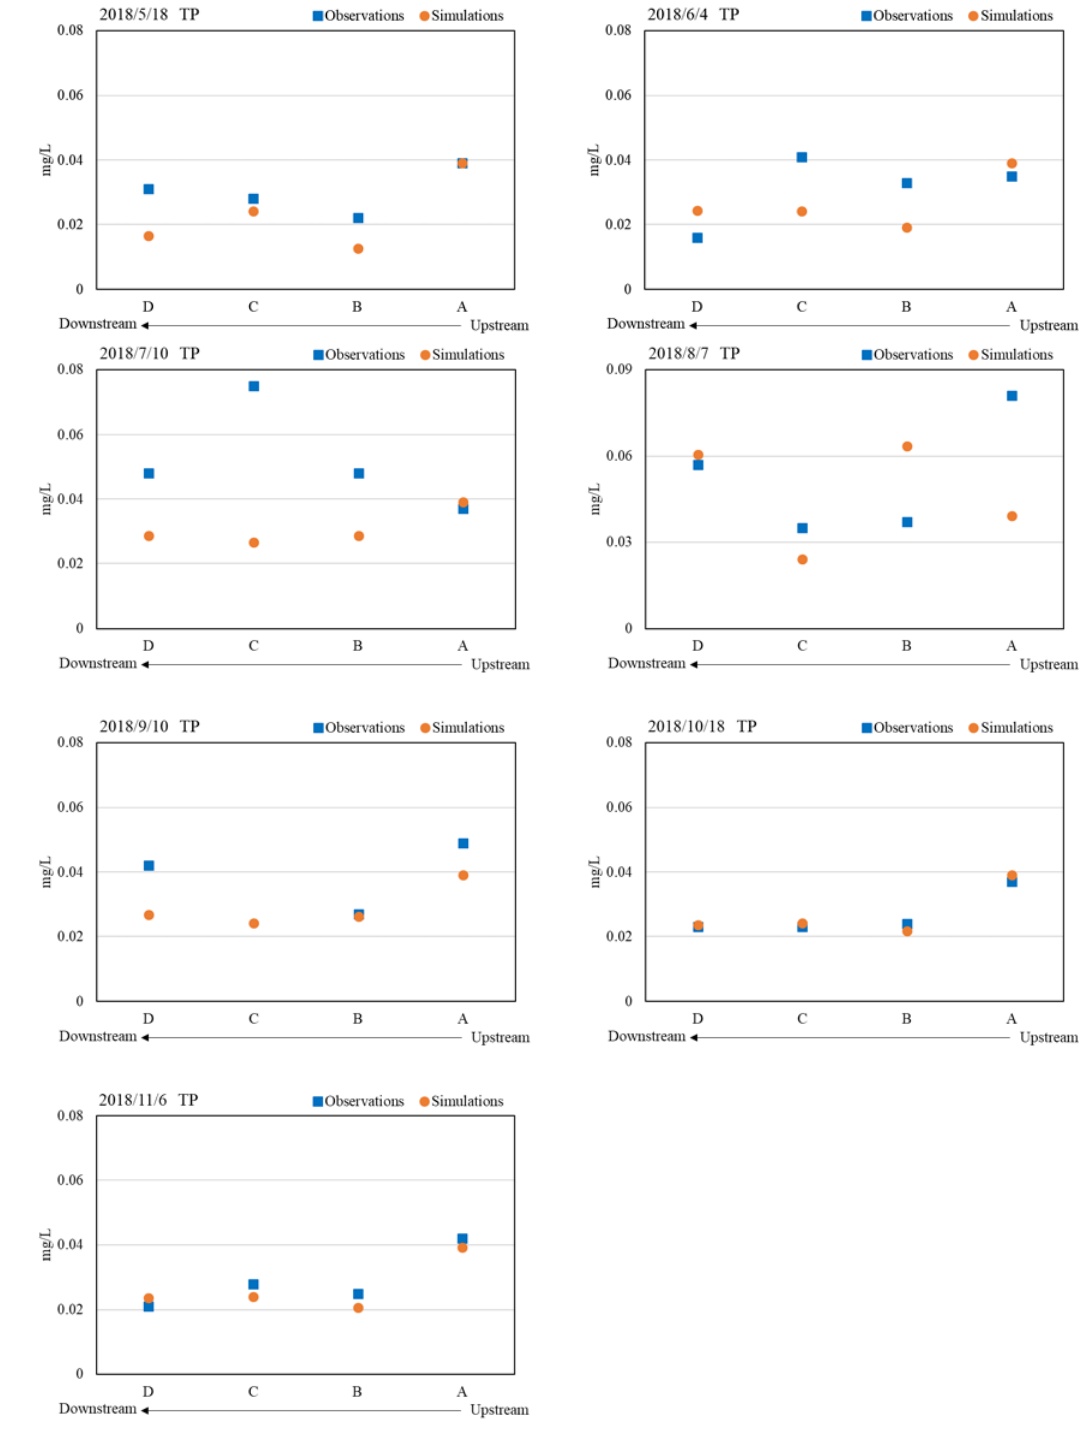
Figure 6. The total phosphorous (TP) simulations of dry weather events. The data of the 5/18 event are for calibration, and the other 6 events are for verification.